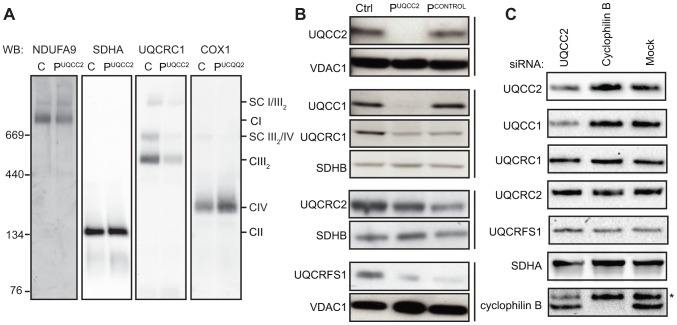
Lack of UQCC2 is associated with aberrant complex III assembly, subunit expression and UQCC1 stability.(A) BN-PAGE immunoblotting of mitochondria lysed in 1% Triton X-100, using antibodies against the NDUFA9 subunit of complex I, the SDHA subunit of complex II, the UQCRC1 subunit of complex III and the COX1 subunit of complex IV shows reduced complex III assembly in PUQCC2. See Figure S6A for quantification of immunoreactive bands. (B) SDS-PAGE and western blotting of mitochondrial lysates from patient fibroblasts demonstrate a marked deficiency of UQCC2 and UQCC1, a mild deficiency in the UQCRC2 subunit of complex III, and a more pronounced deficiency of the UQCRC1 and UQCRFS1 subunits of complex III. The PCONTROL cell line with mutations in a complex III subunit gene showed a similar profile of complex III subunit instability but had levels of UQCC2 and UQCC1 comparable to the wild-type control. The complex II subunit SDHB and mitochondrial VDAC1 protein act as loading controls. Vertical bars indicate immunoblots performed using the same membrane. See Figure S6A for quantification of immunoreactive bands. (C) Mitochondrial lysates of HEK293 cells transfected with siRNA targeting UQCC2 analyzed by SDS-PAGE and western blotting showed reduced levels of UQCC2 and UQCC1 proteins. As control, cyclophilin B knockdown and mock transfected cells were used. The asterisk indicates a non-specific, cross-reactive species. See Figure S7A for quantification of immunoreactive bands.